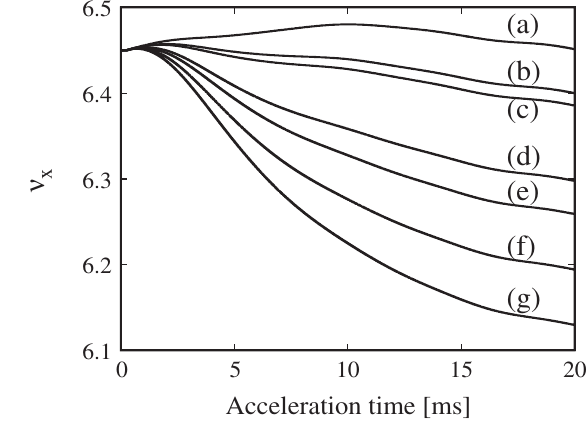
FIG. 19. Manipulation of tune ν x to suppress beam instability at beam power of 1 MW. The ν x at injection is typically set to 6.45, but it has to be manipulated as a function of time in order to stabilize the beam. The ν x without any manipulation corresponds to the line denoted by